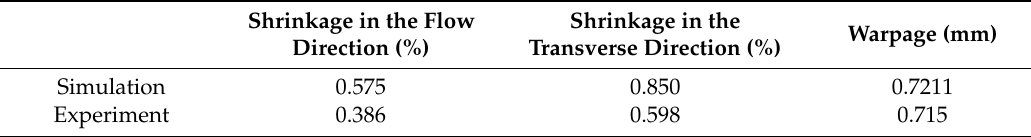
Table 11. Comparison of simulation and experimental results.